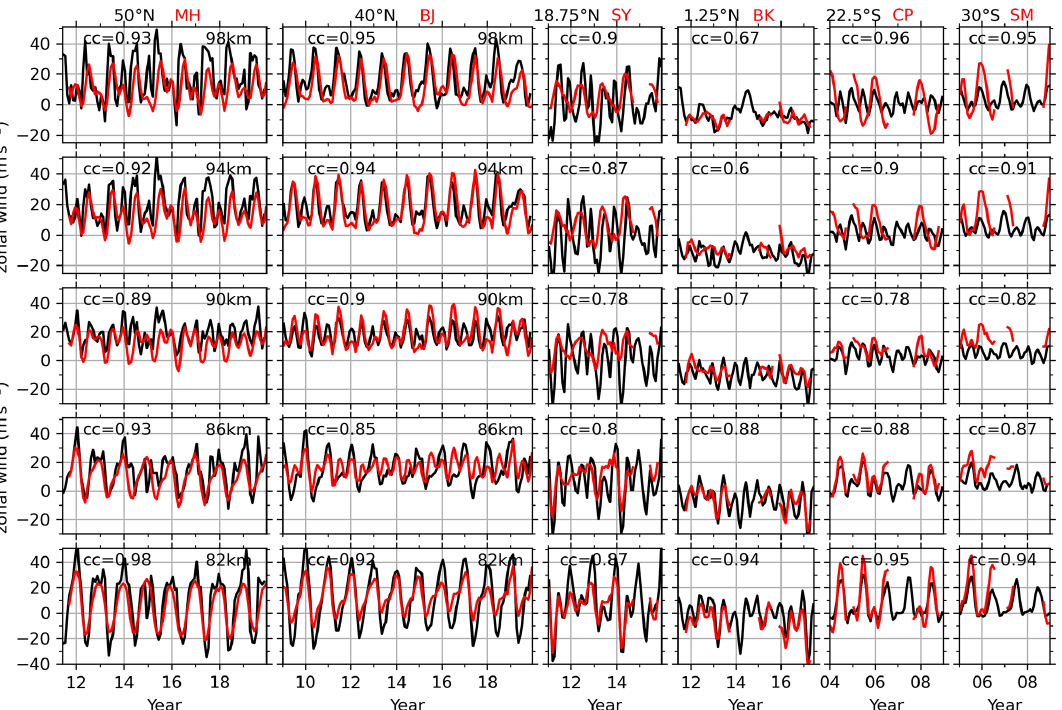
Figure 8. Monthly mean zonal wind from meteor radars (red lines, positive for eastward) at (from left to right) MH (53.5 ◦ N), BJ (40.3 ◦ N), SY (18.3 ◦ N), BK (1.2 ◦ S), CP (22.7 ◦ S), and SM (29.7 ◦ S) stations and the BU (black) at a similar latitude (labeled at the top of each column) at five heights. The correlation coefficient (cc) between BU and MetU is labeled on each panel. The same y axis is used in each row. The ticks on the x axis mark the beginning of each